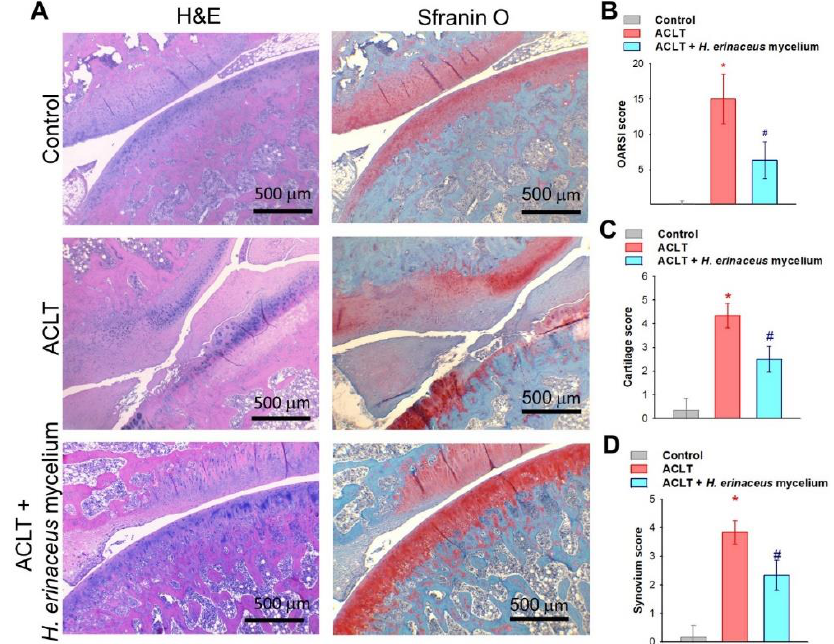
Figure 4. H. erinaceus mycelium ameliorates ACLT-induced cartilage degradation and synovial inflammation. ( A ) Histological sections from knees stained with H&E and Safranin-O. ( B ) OARSI scores, ( C ) cartilage scores and ( D ) synovium scores ( n = 6 for each group). * p < 0.05 compared to the control group; # p < 0.05 compared to the ACLT-only group.